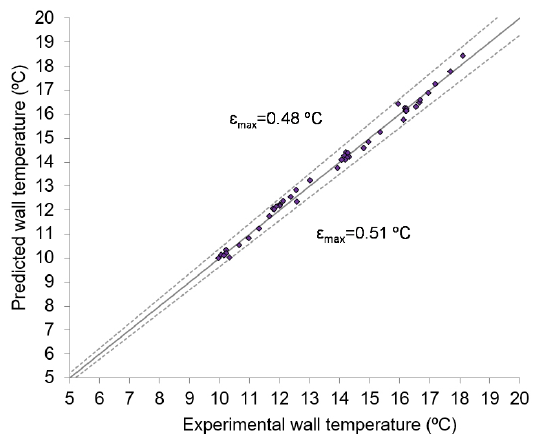
Figure 12. The deviation between calculated and experimental values of the wall temperature.